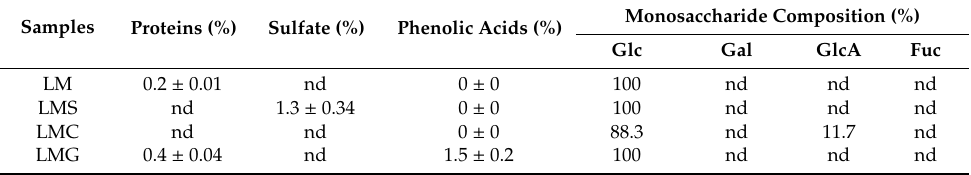
Table 1. Chemical contents and monosaccharide composition of LM, LMS, LMC, and LMG. Monosaccharide Composition (%) Samples Proteins (%) Sulfate (%) Phenolic Acids (%) Glc Gal GlcA Fuc LM 0.2 ± 0.01 nd 0 ± 0 100 nd nd nd LMS nd 1.3 ± 0.34 0 ± 0 100 nd nd 0 ±